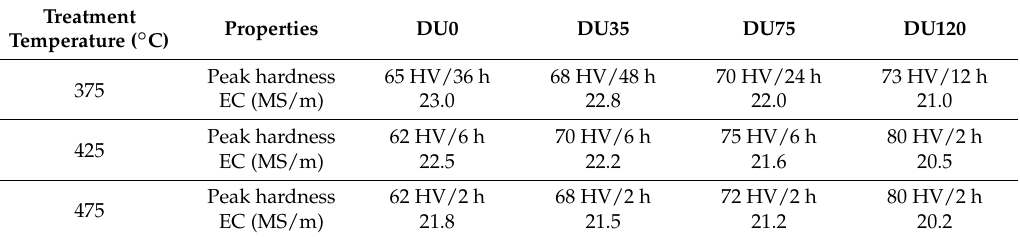
Table 2. Peak hardness values and their corresponding times and electrical conductivity.